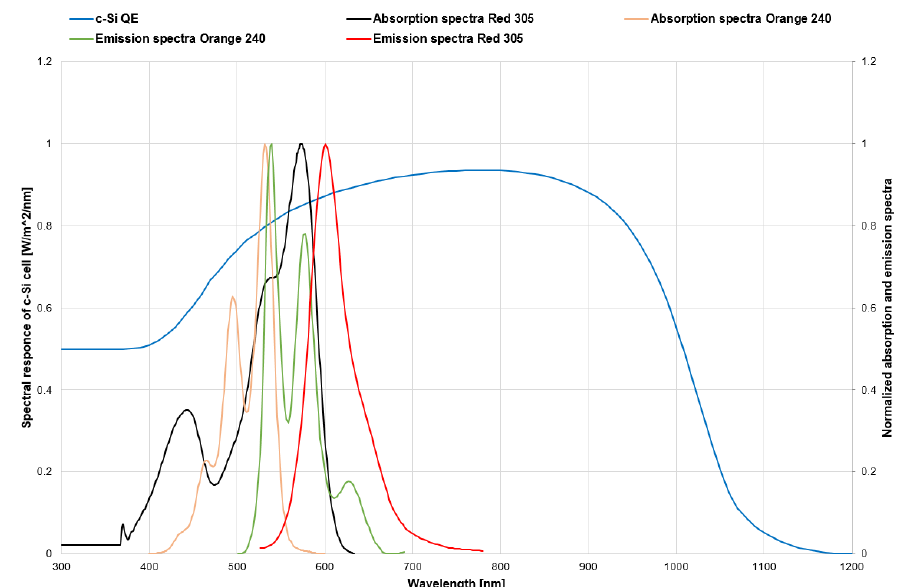
Figure 4. The quantum efficiency curve of a silicon solar cell versus the normalized absorption and emission spectra of the Lumogen red 305 and orange 240 dyes.